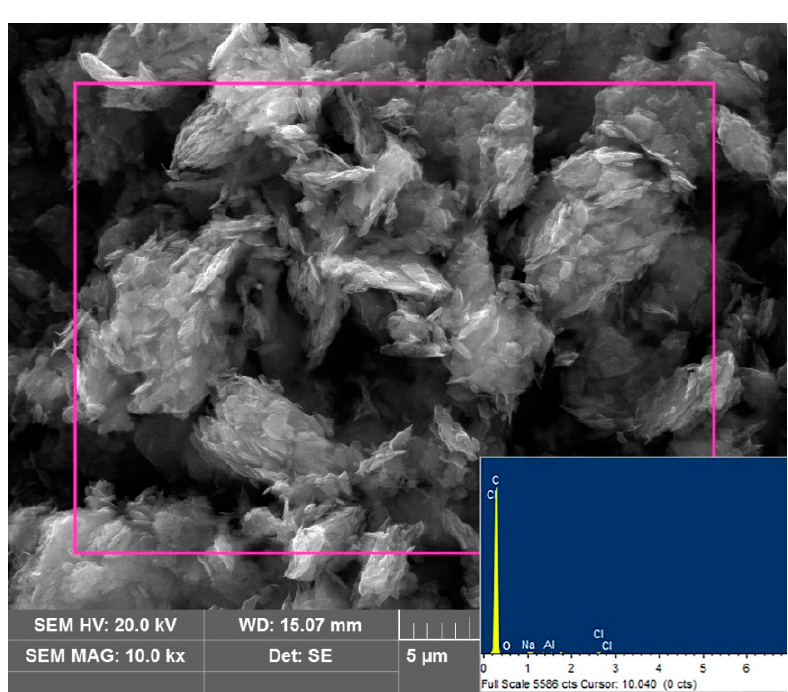
Figure 9. SEM-EDS images of SCC after alkali fusion-acid leaching treatment.